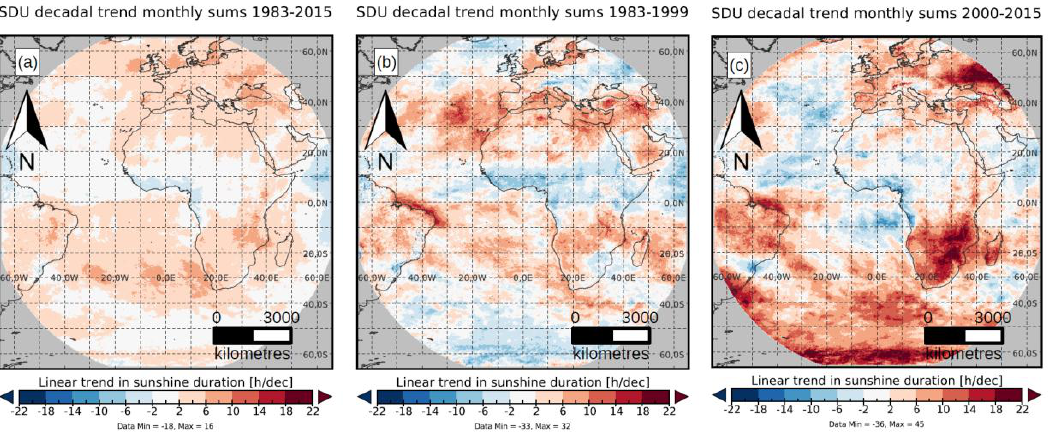
Figure 10. Linear decadal trend in SDU for the time period 1983 to 2015 ( a ), 1983 to 1999 ( b ), 2000 to 2015 ( c ).